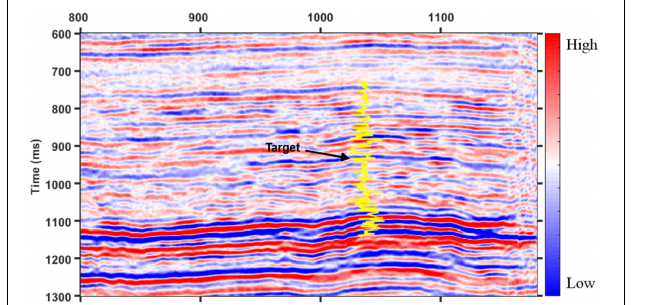
FIGURE 9 | Post-stacked seismic profile across well A.